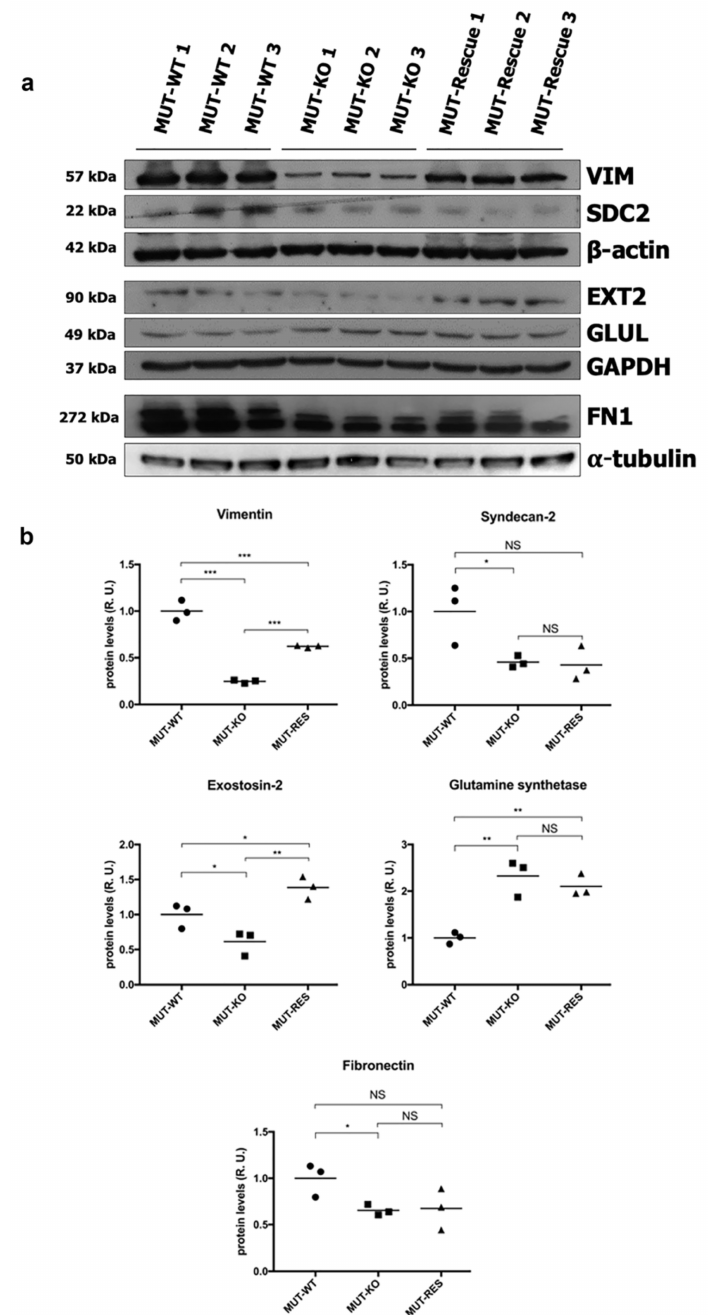
Figure 6. Validation of proteomic results and expression levels analysis in MUT-Rescue cells. According to the results of the proteomic LFQ, the downregulation of VIM, SDC2, EXT2, FN1, and the upregulation of GLUL were confirmed in MUT-KO cells by WB. The expression levels of these proteins were also measured in MUT-Rescue cells. ( a ) The panel reports blot scans of X-ray films for each tested protein and their loading controls. ( b ) Densitometry analysis results are reported as the mean ± SD of three biological replicates each normalized to the amount of α -tubulin, β -actin, or GAPDH proteins. A one-way two-tail t -test was used to calculate the statistical significance of di ff erences between the three groups ( p value). *: p < 0.05; **: p < 0.01; ***: p < 0.005; NS: Not significant ( p >